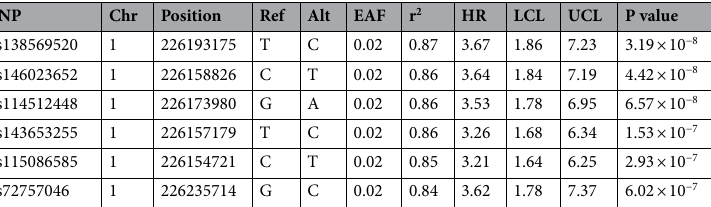
Table 1. Results for the six correlated variants associated with breast cancer-specific survival for patients with metastatic primary breast cancer at diagnosis. Genomic positions are based on the hg19 genome build. ALT alternate, REF reference, EAF effect allele frequency, HR hazard rate, LCL lower control limit, UCL upper control limit, r 2 imputation quality.